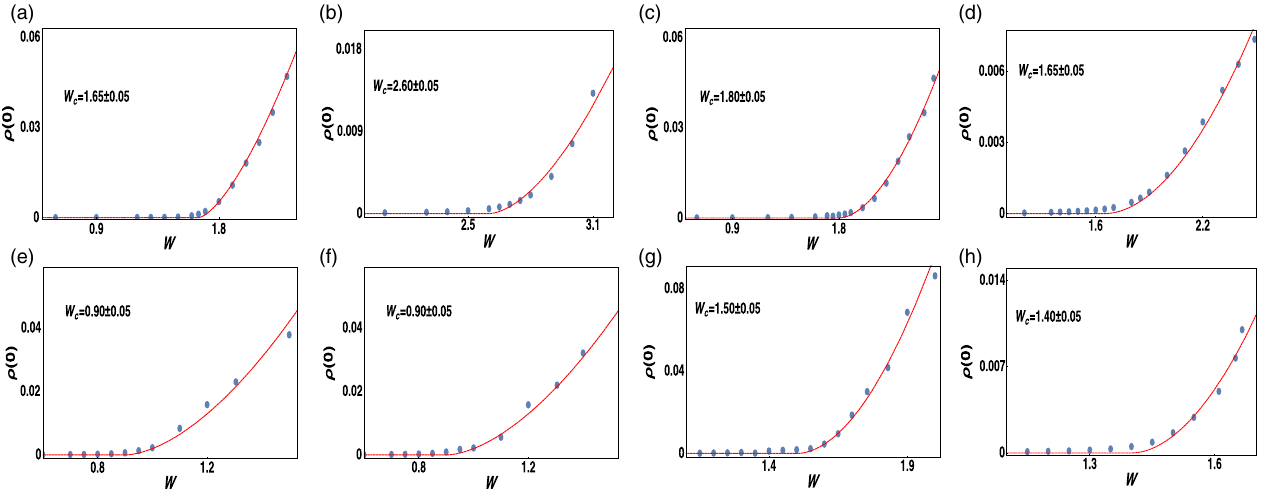
FIG. 22. Scaling of the ADOS at zero energy [ ϱ ð 0 Þ ] as a function of disorder strength W (chosen to be uniformly and independently distributed within a box ½ − W; W (cid:3) ) for (a) potential, (b) axial, (c) axial current (or magnetic), (d) current, (e) temporal tensor (or spin- orbit), (f) spatial tensor (or axial magnetic), (g) scalar mass, and (h) pseudoscalar mass disorder. The results are obtained by using KPM in a cubic lattice with linear dimension L ¼ 220 in each direction. Note ϱ ð 0 Þ is pinned to zero up to a critical strength of disorder W quoted in each panel (see also Tables I and II), and then it becomes finite, indicating the onset of a metallic phase. We reduce the uncertainty in determining the location of W within the error bar (cid:2) 0 . 05 , allowing us to minimize the fitting error in the determination of c z and ν (see Appendix E and Table